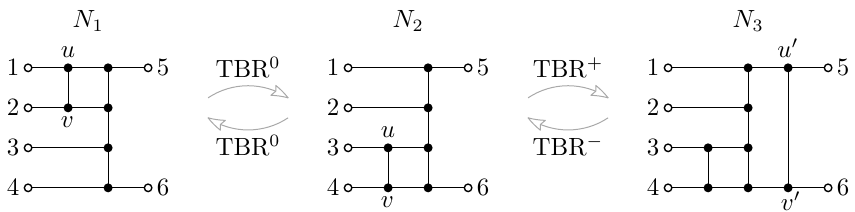
Figure 4: Illustration of the TBR operation. The network N by a TBR 0 that moves the edge { u, v } and the network N a TBR + that adds the edge { u (cid:48) , v (cid:48) } . Each operation has its corresponding TBR 0 and TBR − operation, respectively, that reverses the